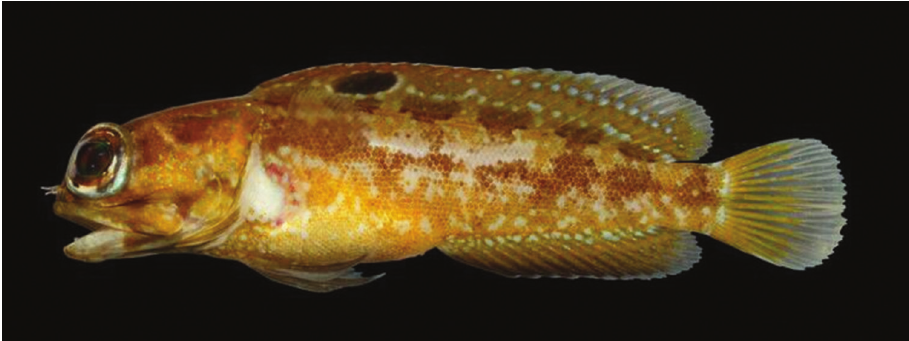
Figure 12. Opistognathus brasiliensis , CIUFES 3361, 60.6 mm SL, female, Ilhas Escalvada, Guarapari, Espírito Santo, Brazil. Photograph by Raphael M. Macieira.